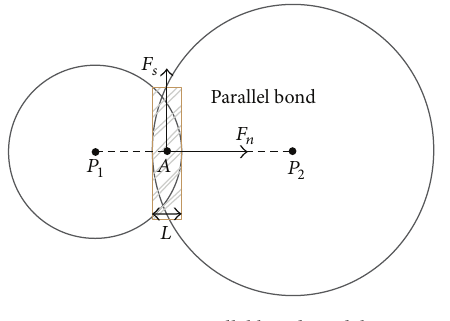
Figure 2: A parallel bond